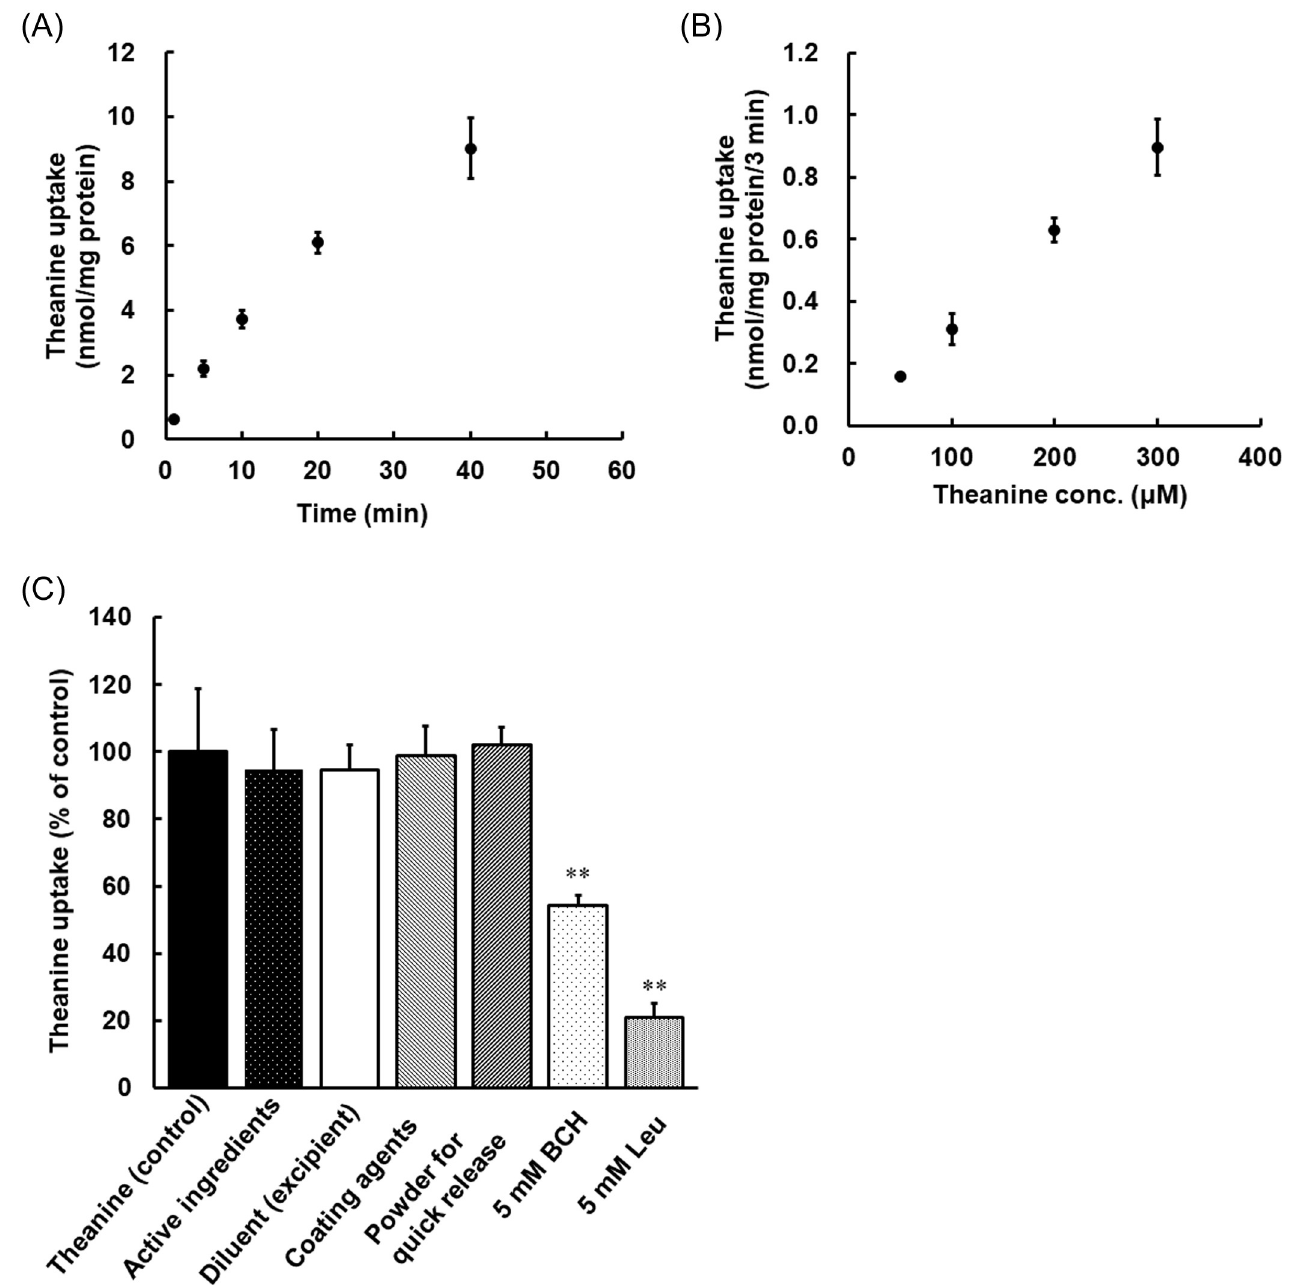
Fig 2. Time course (A) and concentration-dependence (B) of theanine accumulation and inhibitory effect of a mixture of ingredients and inhibitors of transporter on uptake of theanine (C) in Caco-2 cells. The uptake of theanine (500 μ M) at 1, 5, 10, 20 and 40 min (A) and the accumulation of theanine (50, 100, 200 and 300 μ M) (B) were measured at pH 7.4 at 37˚C. The accumulation of theanine (200 μ M) was measured at pH 7.4 at 37˚C in the absence (control) and presence of a mixture of ingredients or inhibitors (5 mM of BCH or leucine) (C). The concentration of theanine was determined using an LC/MS. Each point represents the mean with S.D. of 3–4 measurements. �� ; significantly different from the control at p <